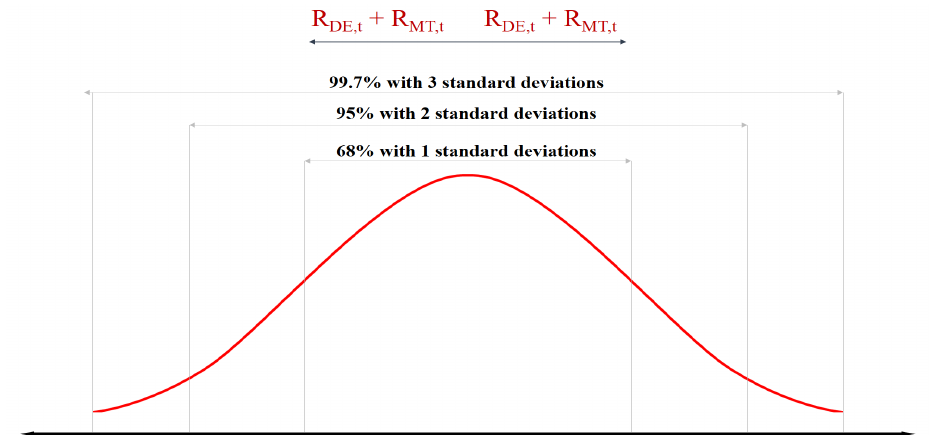
Figure 2. Normal distribution plot obtained from historical